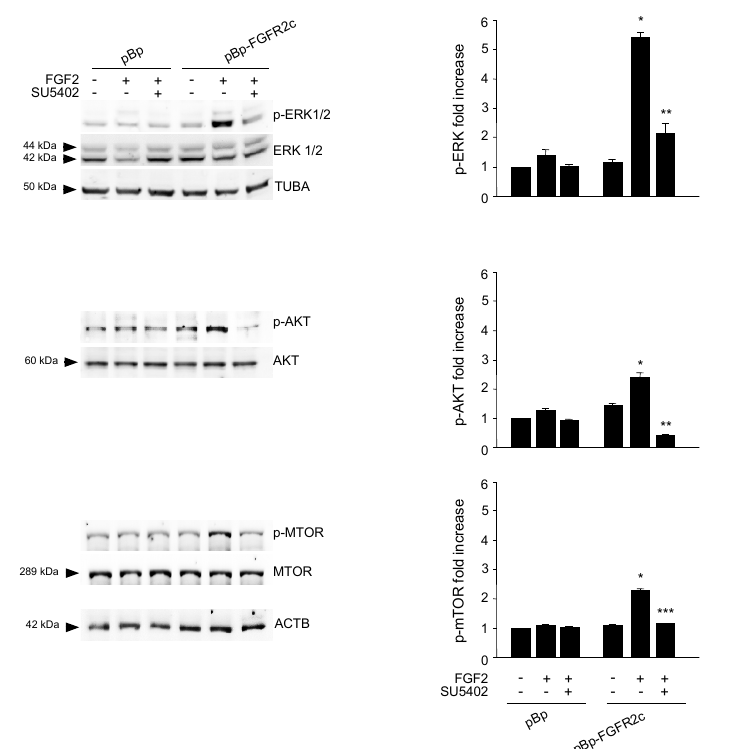
Figure 3. FGF2 stimulation activates ERK1 / 2 and AKT / MTOR signaling pathways in HaCaT pBp-FGFR2c. HaCaT pBp and HaCaT pBp-FGFR2c clones were left untreated or stimulated with FGF2 in the presence or absence of the FGFR2 tyrosine kinase inhibitor SU5402, as above. Western blot analysis performed using an antibody directed against the phosphorylated form of ERK1 / 2, AKT and MTOR demonstrates the activation of each substrates only in HaCaT pBp-FGFR2c upon FGF2 stimulation. These e ff ects were abolished by SU5402 treatment. Equal loading was assessed with anti-ERK1 / 2, anti-AKT, and anti-MTOR antibodies. Densitometric analysis and Student’s t test were performed as reported above. * p < 0.05 vs the corresponding FGF2-unstimulated cells; ** p < 0.05 and *** p < 0.01 vs the corresponding SU5402-untreated cells.